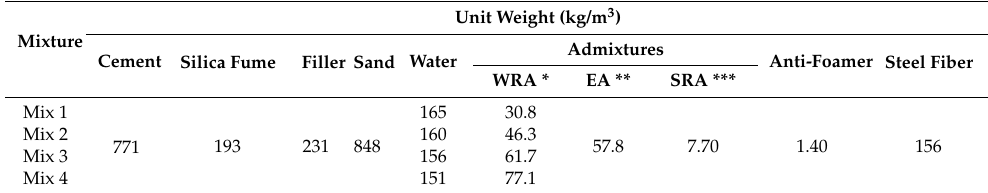
Table 1. Mix proportion of ultra-high-performance fiber-reinforced concrete (UHPFRC).